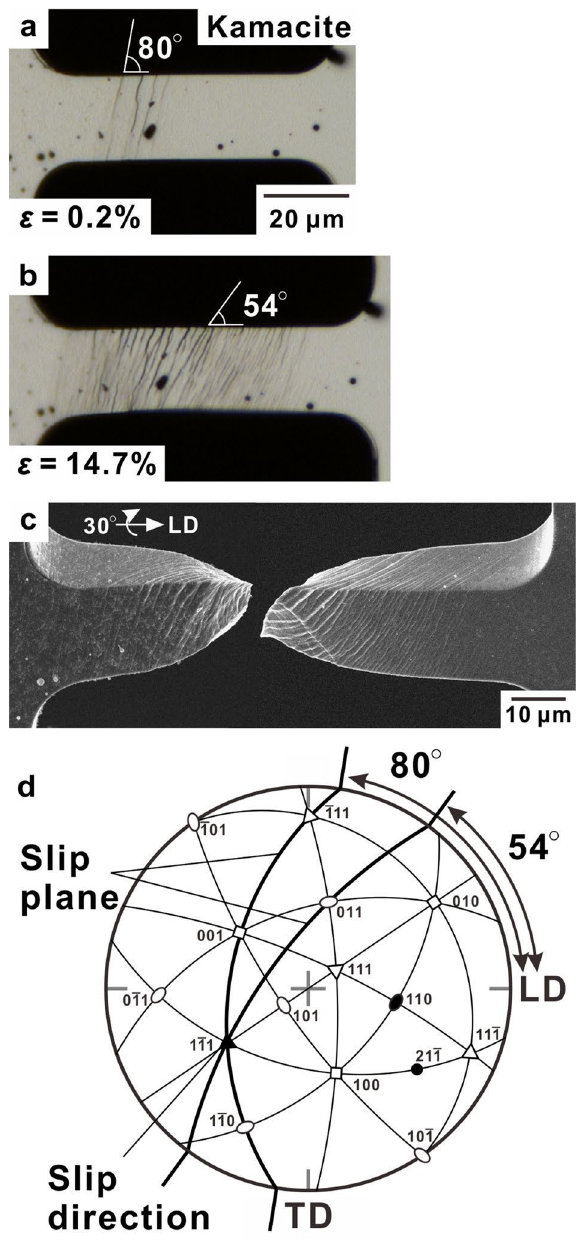
Figure 3. Deformation and fracture behaviour in the single-crystalline kamacite specimen. ( a , b ), Optical micrographs captured during deformation at nominal strains, ε , of 0.2% and 14.7%, respectively. ( c ) Scanning electron microscopy image showing the fracture morphology. ( d ) Stereographic projection of the kamacite specimen in the initial state with related slip